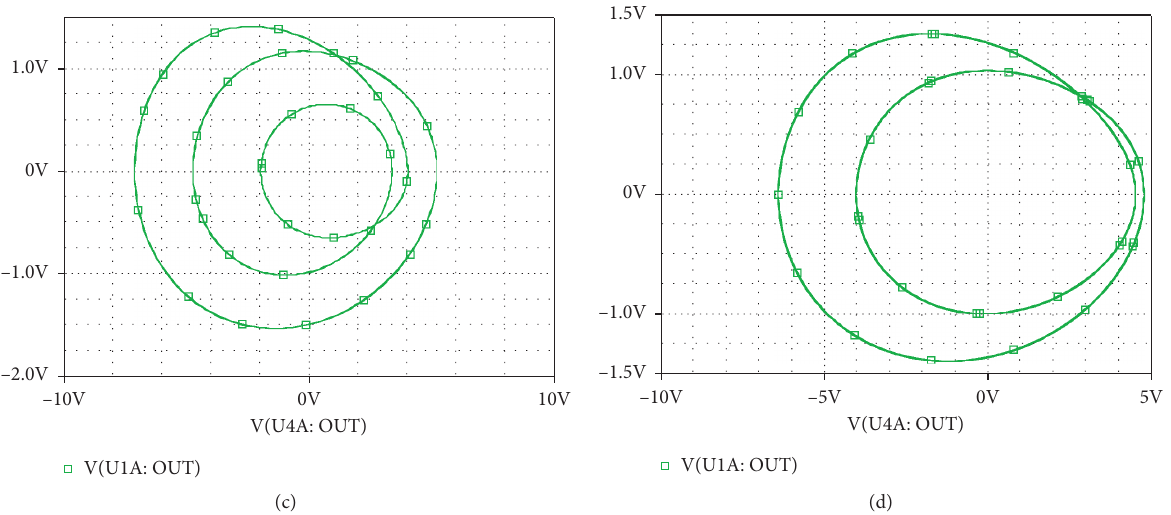
Figure 19: PSpice simulation results showing the coexistence of four different asymmetric attractors for R � 12k Ω , and R � 576k Ω obtained with four different initial conditions ( v R c k for ( 0 . 4 , 0 . 0 , 0 . 0 ) ; (b) a chaotic attractor for ( 0 . 2 , 0 . 0 , 0 . 0 ) ; (c) a period-3 limit cycle for (− 0 . 303 , 0 . 0 , 0 . 0 ) ; (d) a period-2 limit cycle for (− 1 . 8 , 0 . 0 , 0 . 0 )